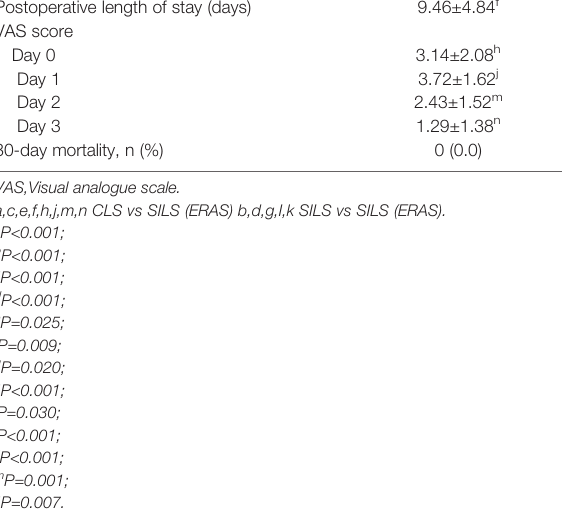
TABLE 5 | Data related to postoperative function. Parameter CLS SILS Duration before fi rst fl atus